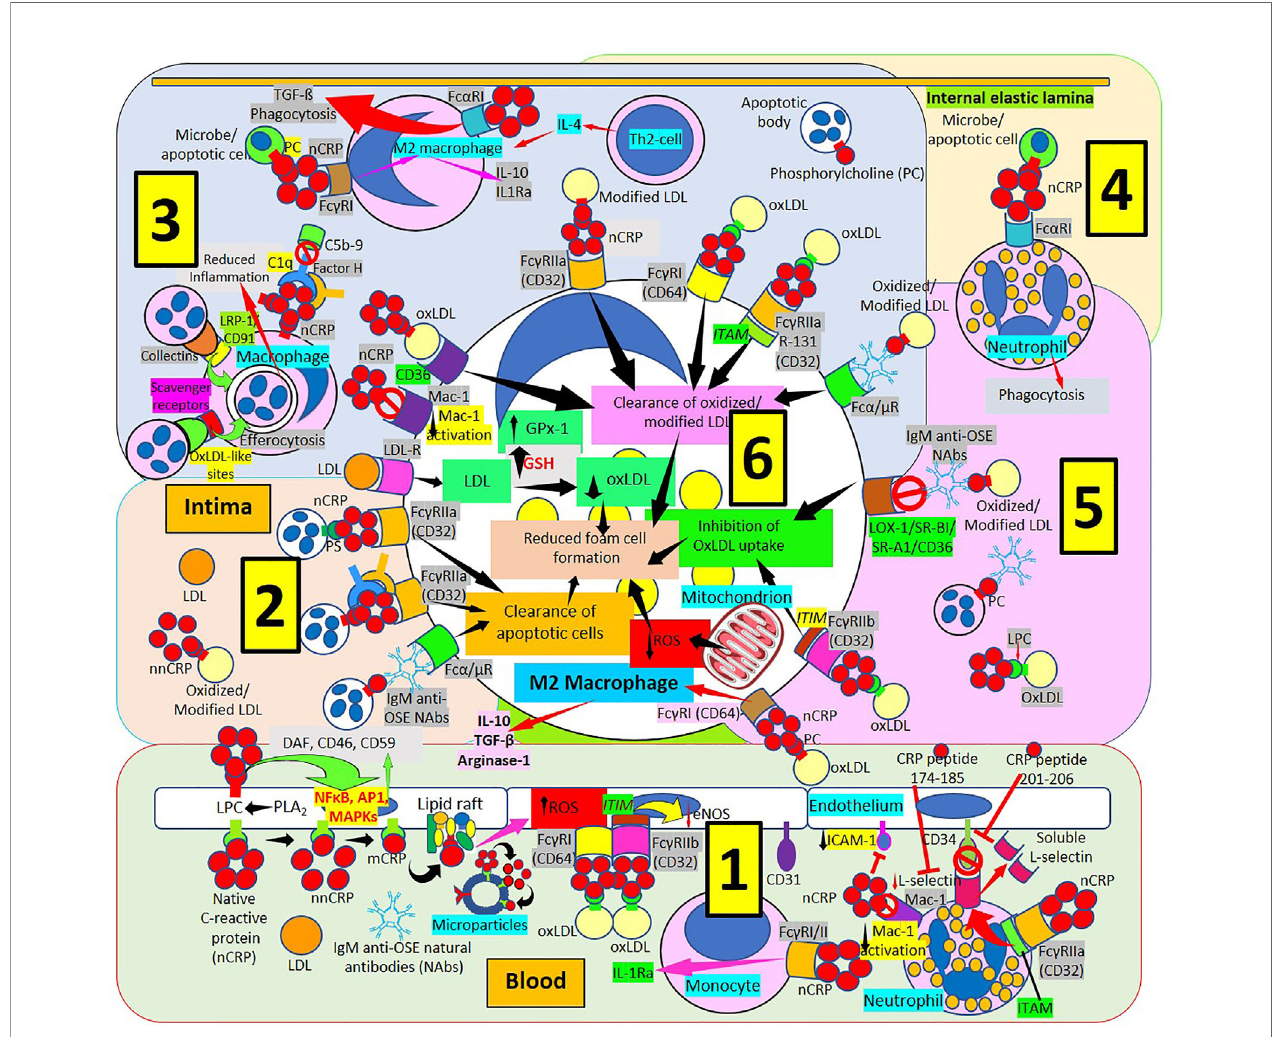
FIGURE 6 | C-reactive protein innate immunoprotective responses in atherosclerotic lesions. [1] Native pentameric C-reactive protein (nCRP) and CRP peptides prevent neutrophil adhesion by downregulating L-selectin expression through activation of Fc g receptor (R) IIa and immunoreceptor tyrosine-based activation motif (ITAM), and by inducing L-selectin shedding; nCRP downregulates CD11b/CD18 (Mac-1) receptor activation and endothelial intercellular adhesion molecule-1 (ICAM- 1) expression (right in 1). Native pentameric CRP induces Fc g R-mediated interleukin (IL)-1 receptor antagonist (Ra) expression in mononuclear cells (middle in 1). CRP bound to oxLDL can reduce endothelial nitric oxide synthase (eNOS) through Fc g Rs and immunoreceptor tyrosine-based inhibitory motif (ITIM) activation (middle in 1). Circulating nCRP bound to cellular or microparticle lysophosphatidylcholine (LPC) generated by phospholipase A 2 (PLA 2 ), or to phosphorylcholine (PC) can be dissociated to monomeric CRP (mCRP) with intermediate formation of non-native CRP (nnCRP), and mCRP can bind lipid rafts and increase reactive oxygen species (ROS) formation (left in 1). Native CRP can prevent cell damage by enhancing membrane-bound expression of complement regulators decay-accelerating factor (DAF), membrane cofactor protein (CD46) and CD59 mediated by transcription factor (nuclear factor kappa B, NF k B; activator protein 1, AP-1; mitogen- activated protein kinases, MAPKs) activation. [2] The clearance of apoptotic cells is facilitated by immunoglobulin M anti-oxidation speci fi c epitopes natural antibodies (IgM anti-OSE NAbs) and Fc a / m Rs; nCRP-PC, complement 1q (C1q), factor H and Fc g RIIa; and nCRP-phosphatidylserine (PS) and Fc g RIIa, respectively. Low- density lipoproteins (LDL) uptake occurs via LDL-Rs. [3] Native CRP downregulates Mac-1 activation. Native CRP, C1q and factor H; collectins bound to low density lipoprotein receptor-related protein (LRP)-1/CD91; and oxLDL-like sites bound to scavenger receptors facilitate efferocytosis. CRP bound to PC and Fc g RI induces M2 macrophage differentiation that reduces in fl ammation through IL-10 and IL-1R antagonist (IL1Ra) secretion. Th2 T-lymphocytes release IL-4 further inducing M2 macrophages. CRP binds Fc a RI facilitating transforming growth factor-ß (TGF-ß) release and phagocytosis. Fc g Rs CD32 and CD64, scavenger receptor CD36, Fc g RIIa R131 and Fc a / m R facilitate clearance of oxidized/modi fi ed LDL. [4] Fc a RI mediates nCRP neutrophil stimulation of phagocytosis. [5] Immunoglobulin M (IgM) anti oxidation-speci fi c epitopes (OSE) blocks scavenger receptors lectin-like oxidized low-density lipoprotein (LDL) receptor-1 (LOX-1), scavenger receptor class B type 1 (SR-BI), scavenger receptor A1 (SR-A1) and CD36 inhibiting oxLDL uptake. Native CRP through CD32 and immunoreceptor tyrosine-based inhibitory motif (ITIM) inhibits oxLDL uptake; and through CD64 binding induces M2 macrophage differentiation that enhances release of IL-10, TGF-ß and arginase 1. [6] Clearance of oxidized/modi fi ed LDL, inhibition of oxLDL uptake, clearance of apoptotic cells, reduced reactive oxygen species (ROS) and reduced oxLDL formation associated with increased glutathione (GSH) and glutathione peroxidase-1 (GPx-1) activity contribute to reduced foam cell